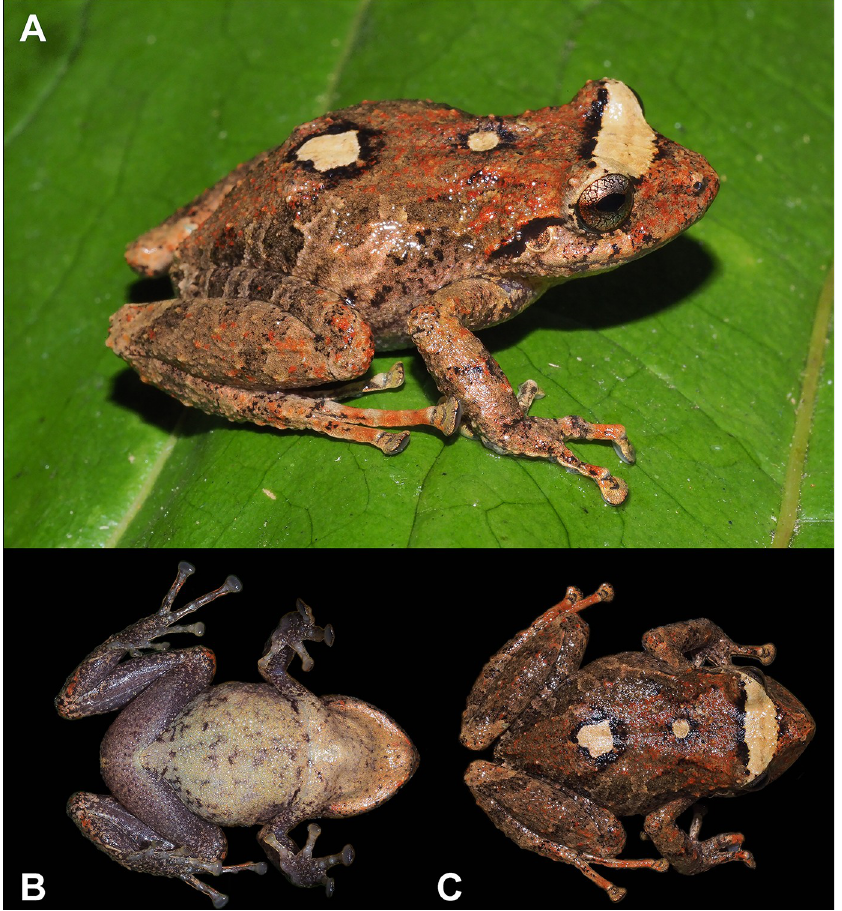
Fig 2. Holotype of Pristimantis lojanus sp. nov. (MUTPL 178, adult female), SVL 35.2 mm, in life. A. Dorsolateral view; B. Ventral view; C. Dorsal view.